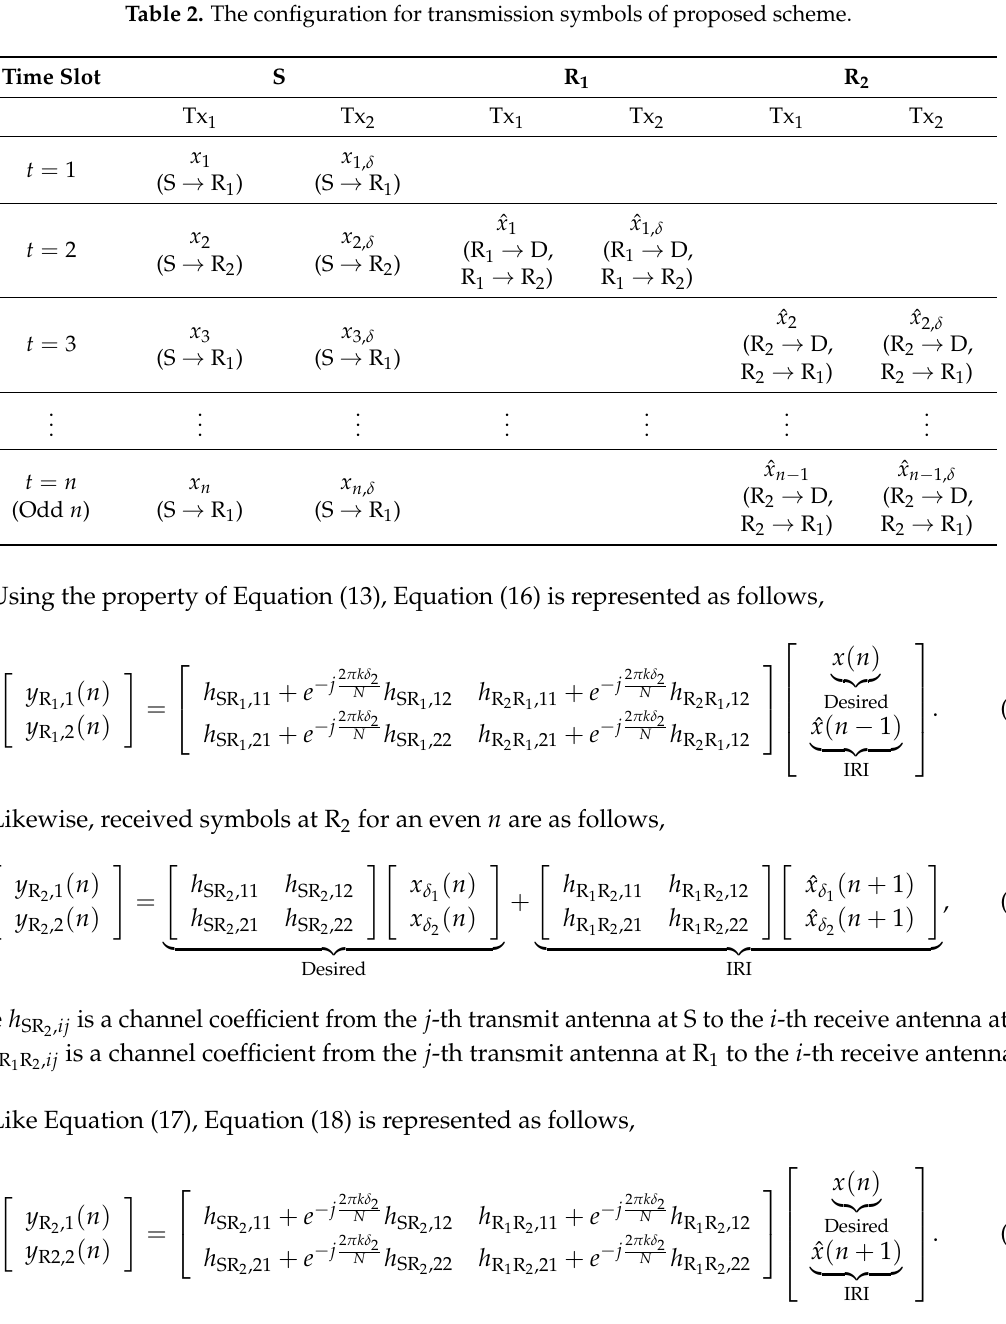
Table 2. The configuration for transmission symbols of proposed